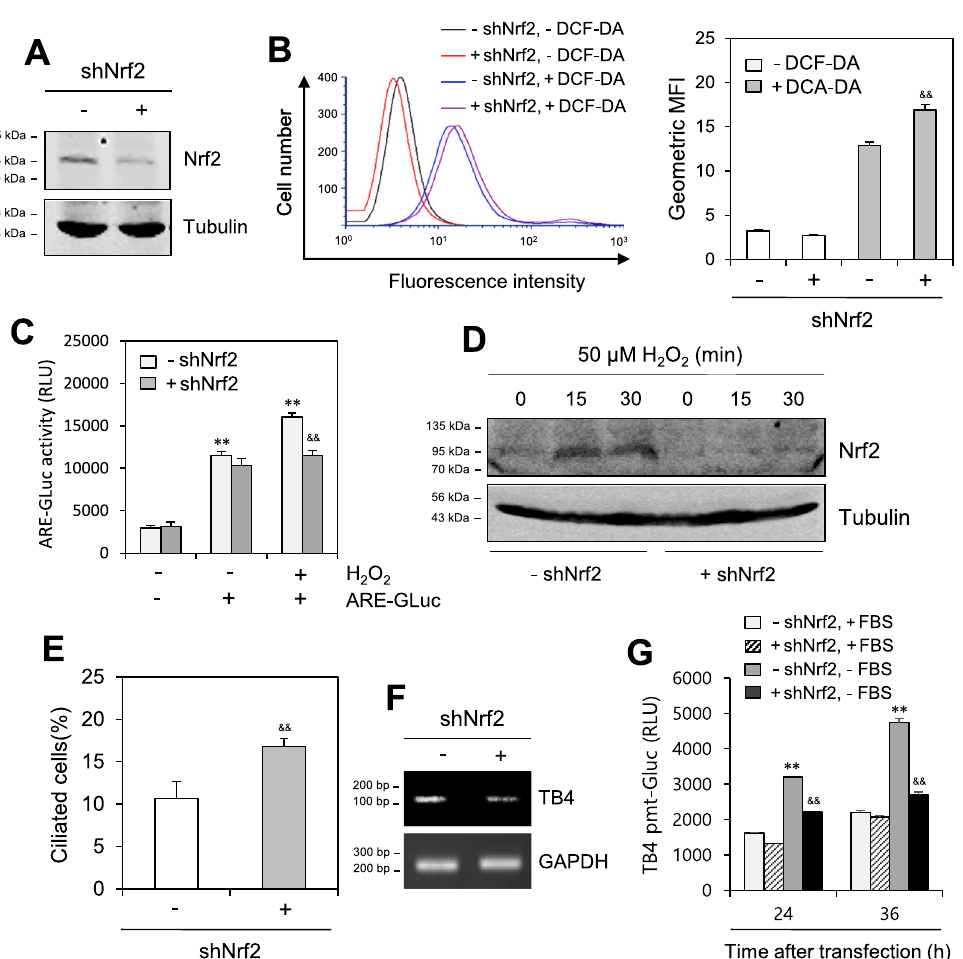
Figure 5. Thymosin beta-4 expression was inhibited in Nrf2-knockdown (KD) cells. ( A – G ) HeLa cells were treated with retroviral shNrf2. Then, shNrf2-positive stable cells were selected by the treatment with hygromycin. Nrf2-KD was induced by the incubation with doxycycline(Dox) for 2 days. Nrf2 proteins were detected by western blotting ( A ). Wildtype (WT) control and Nrf2-KD HeLa cells were treated with DCF-DA. ROS production was measured by FACS analysis ( B , left). Geometric mean fluorescence intensity (MFI) was analyzed by WinMDI 2.8 for each sample ( B , right). WT control and Nrf2-KD HeLa cells were transfected with antioxidant response element (ARE)-Gaussia luciferase (Gluc) plasmid DNA and incubated in the absence or presence of 50 μM H 2 O 2 . ARE-Gluc activity in cultured media was measured with luminometer using Gluc substrate ( C ). WT control and Nrf2-KD HeLa cells were incubated with 50 μM H 2 O 2 for 15 and 30 min. Nrf2 proteins were detected by western blotting ( D ). The cells were fixed and stained with antibody against Ac-tubulin. The ciliated cells out of more than 1000 cells were counted in control (white) and Nrf2-knockdown (grey) group. PC frequency was evaluated by the blinded double scoring ( E ). TB4 transcripts were detected with RT-PCR ( F ). WT control and Nrf2-KD HeLa cells were transfected with pEZX-PG02-TB4-promoter Gaussia luciferase (Gluc) plasmid and incubated in the presence or absence of FBS. The activity of Gluc in cultured media was measured with luminometer using Gluc substrate ( G ). Each result was the representative of experiments performed at least four times and each experiment was performed with four samples (n = 4) in the same group. Processing (such as changing brightness and contrast) is applied equally to controls across the entire image. Original images of full-length blots were included in the Supplementary Information file ( A , D ). Data in bar graphs represents the means ± SD. ** p < 0.01; significantly different from H 2 O 2 -untreated and ARE- untransfected or -transfected group ( C ) or 5% FBS-treated group ( G ). & p < 0.05; && p < 0.01, significantly different from shNrf2-untreated WT control cells ( B , right, C , E , G